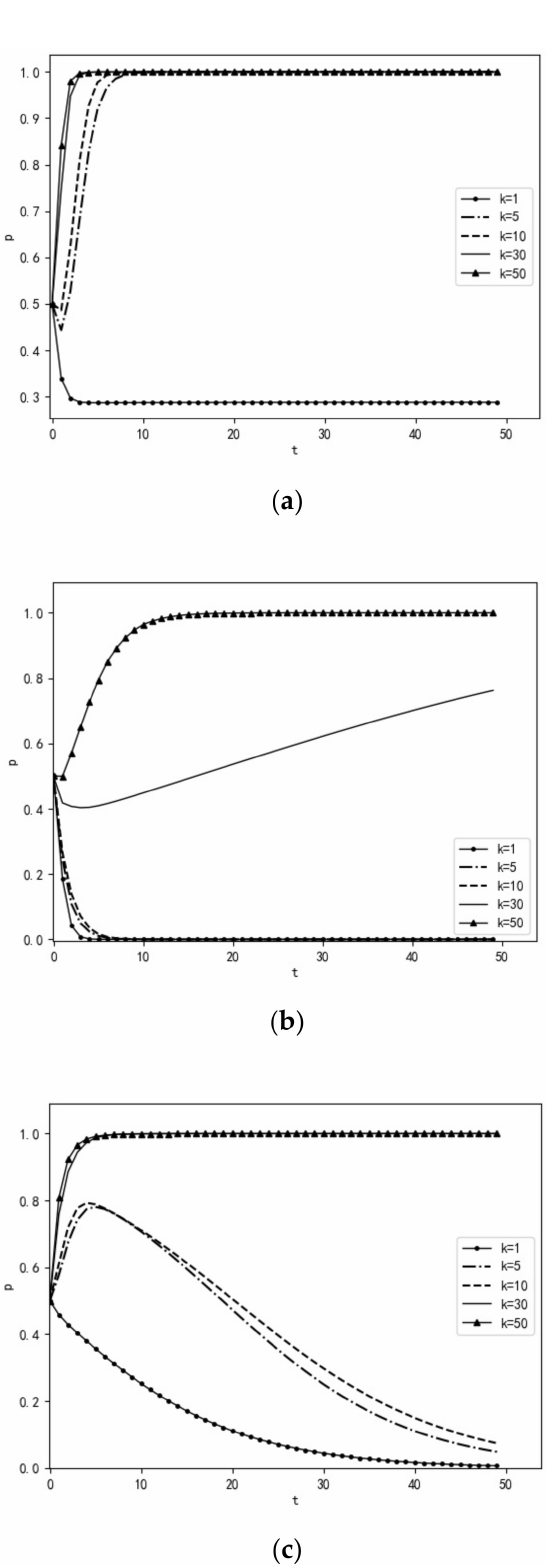
Figure 2. The influence of the initial supervisor node degree on the tripartite evolution strategy. ( a ) The impact of the initial supervisor node on the local government’s evolution strategy. ( b ) The impact of the initial supervisor node degree on the enterprise’s evolution strategy. ( c ) The influence of the initial supervisor node degree on the public’s evolution